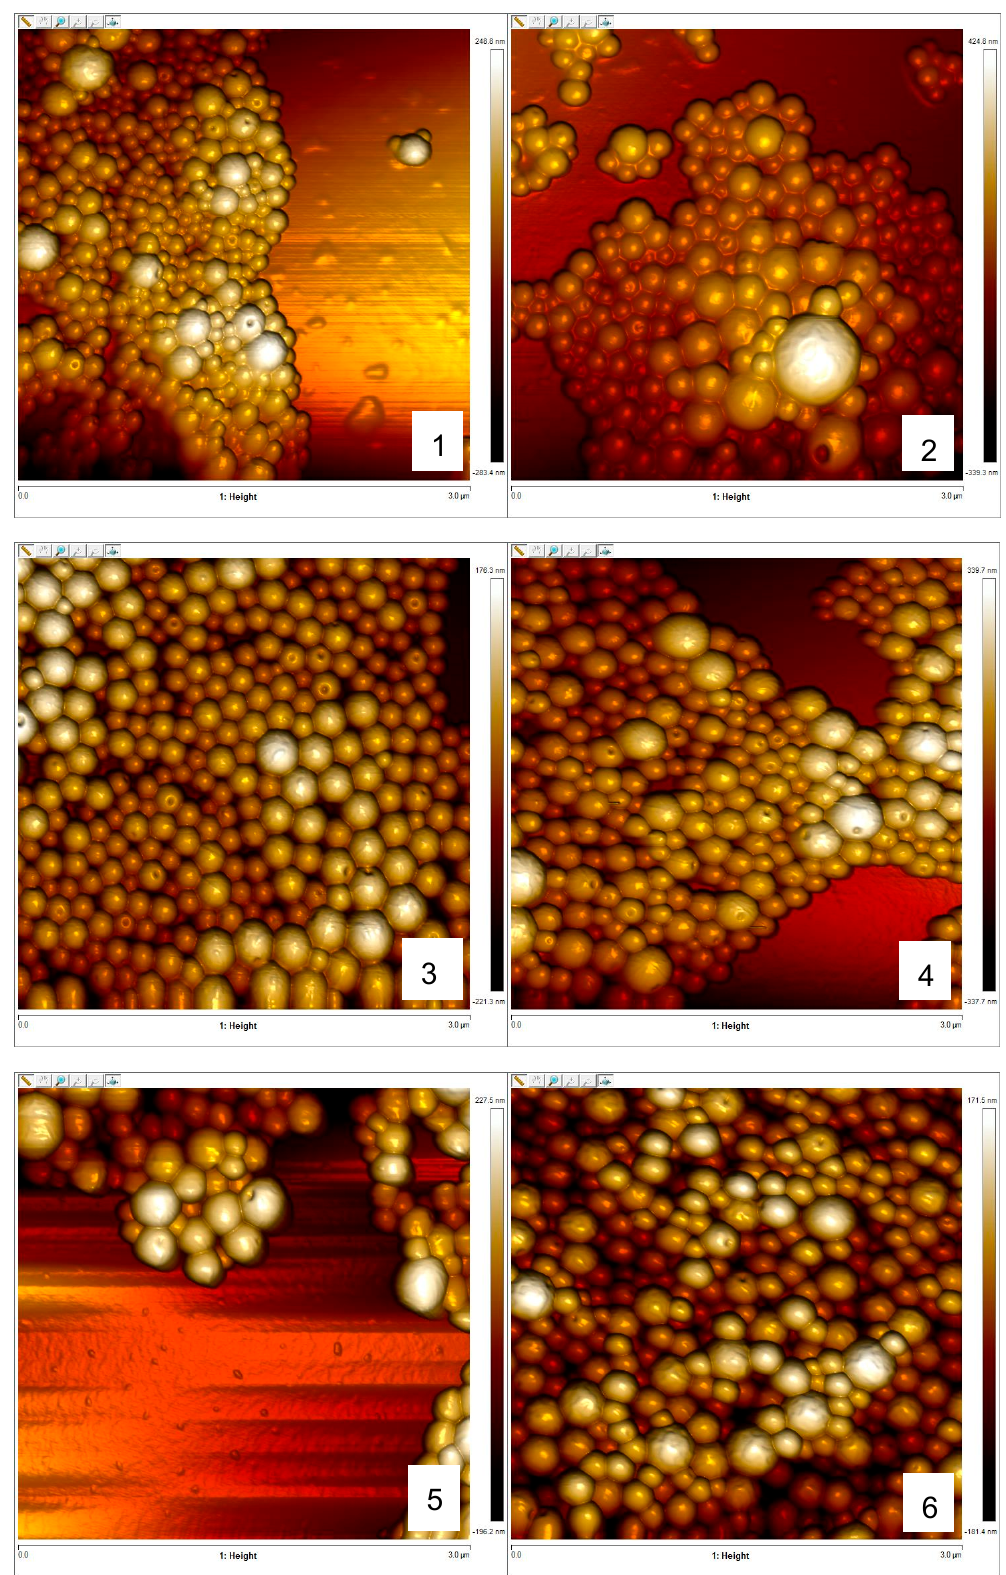
Figure 1. Atomic force microscopy images of formulated nanoparticles. ( 1 ) Empty polylactic acid nanoparticles (PLA-NPs), ( 2 ) α -santonin-PLA-NPs, ( 3 ) arglabin-PLA-NPs, ( 4 ) schkuhrin II-PLA-NPs, ( 5 ) vernolepin-PLA-NPs, and ( 6 ) eucannabinolide-PLA-NPs.